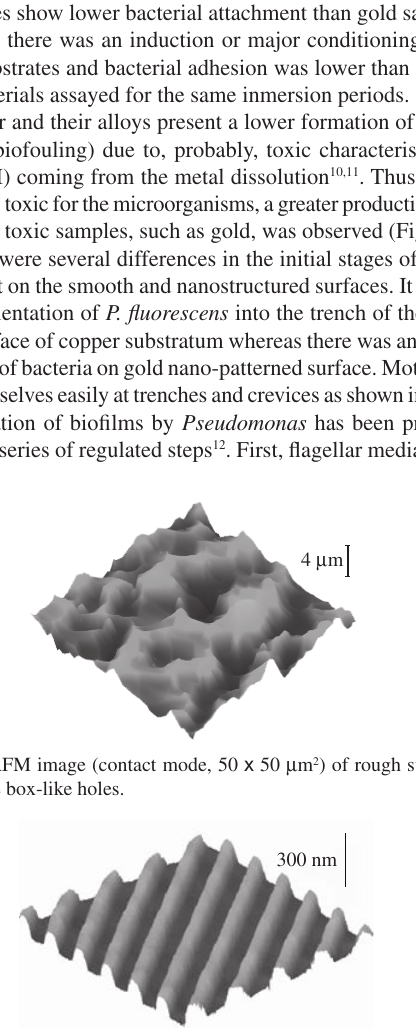
Figure 2. AFM image (contact mode, 10 x 10 µ m 2 ) of Cu nanoestructured surface. The Au samples present the same superficial features.